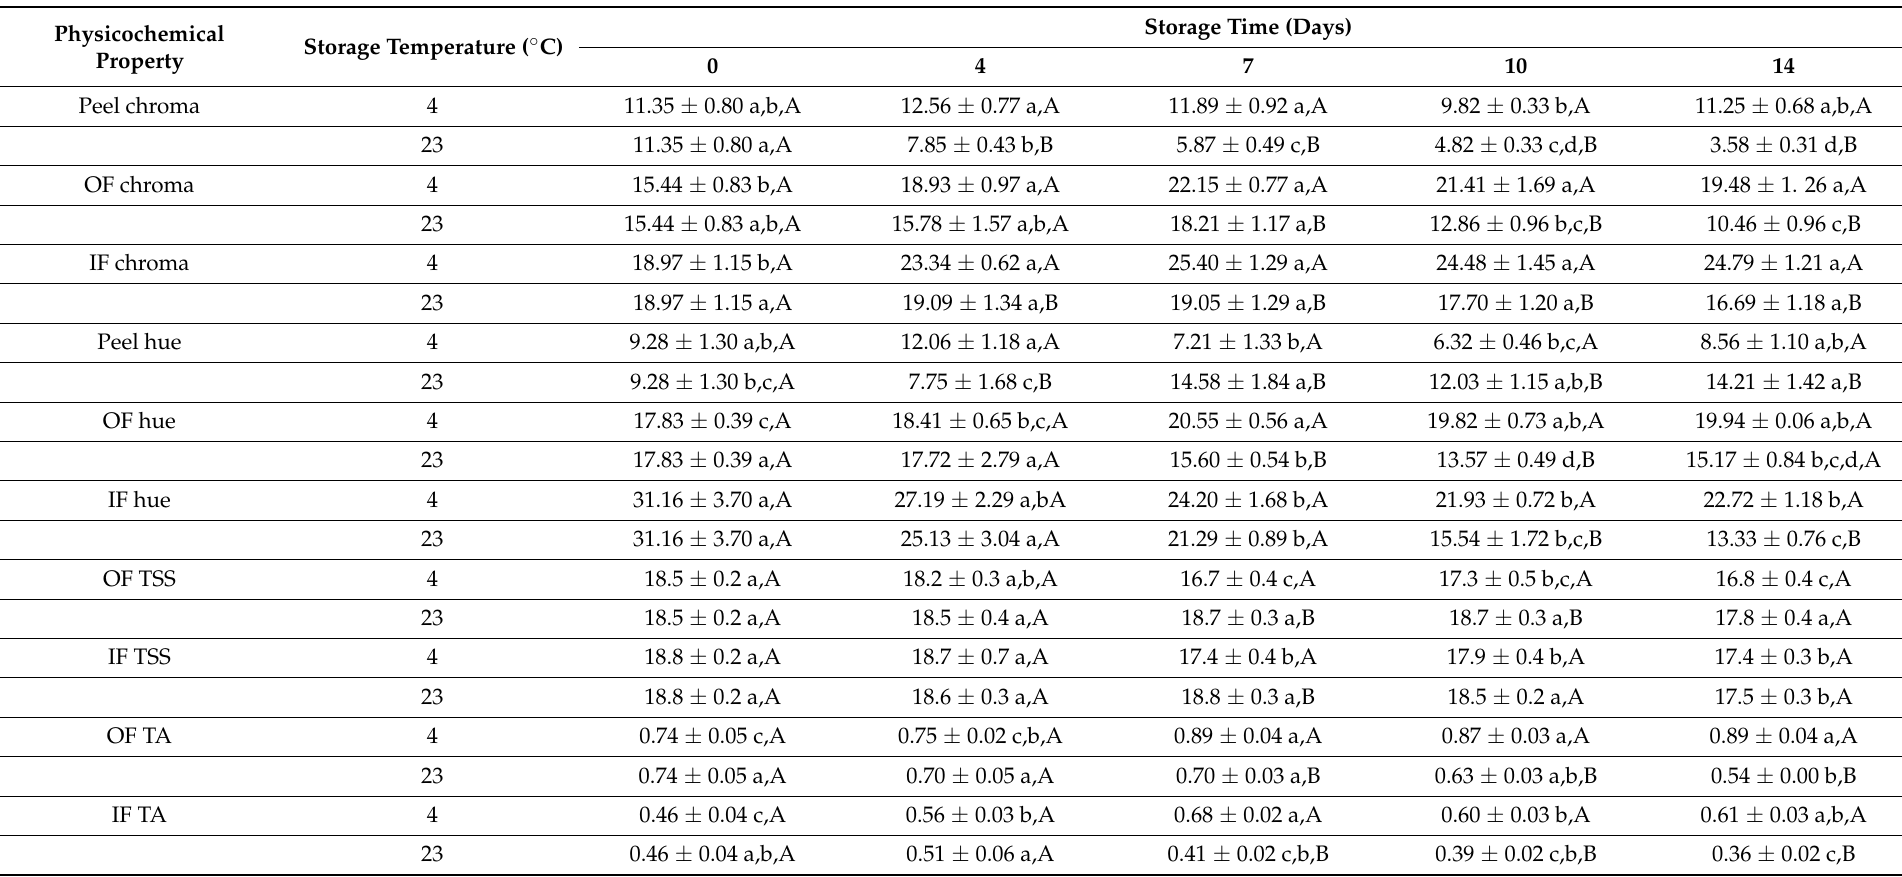
Table 1. Color (chroma and hue angle), total soluble solids (TSS; %), and titratable acidity (TA; as % of malic acid) of the peel, outer flesh (OF) and inner flesh (IF) of Queen Garnet plum (QGP) stored at 4 and 23 ◦ C for 14